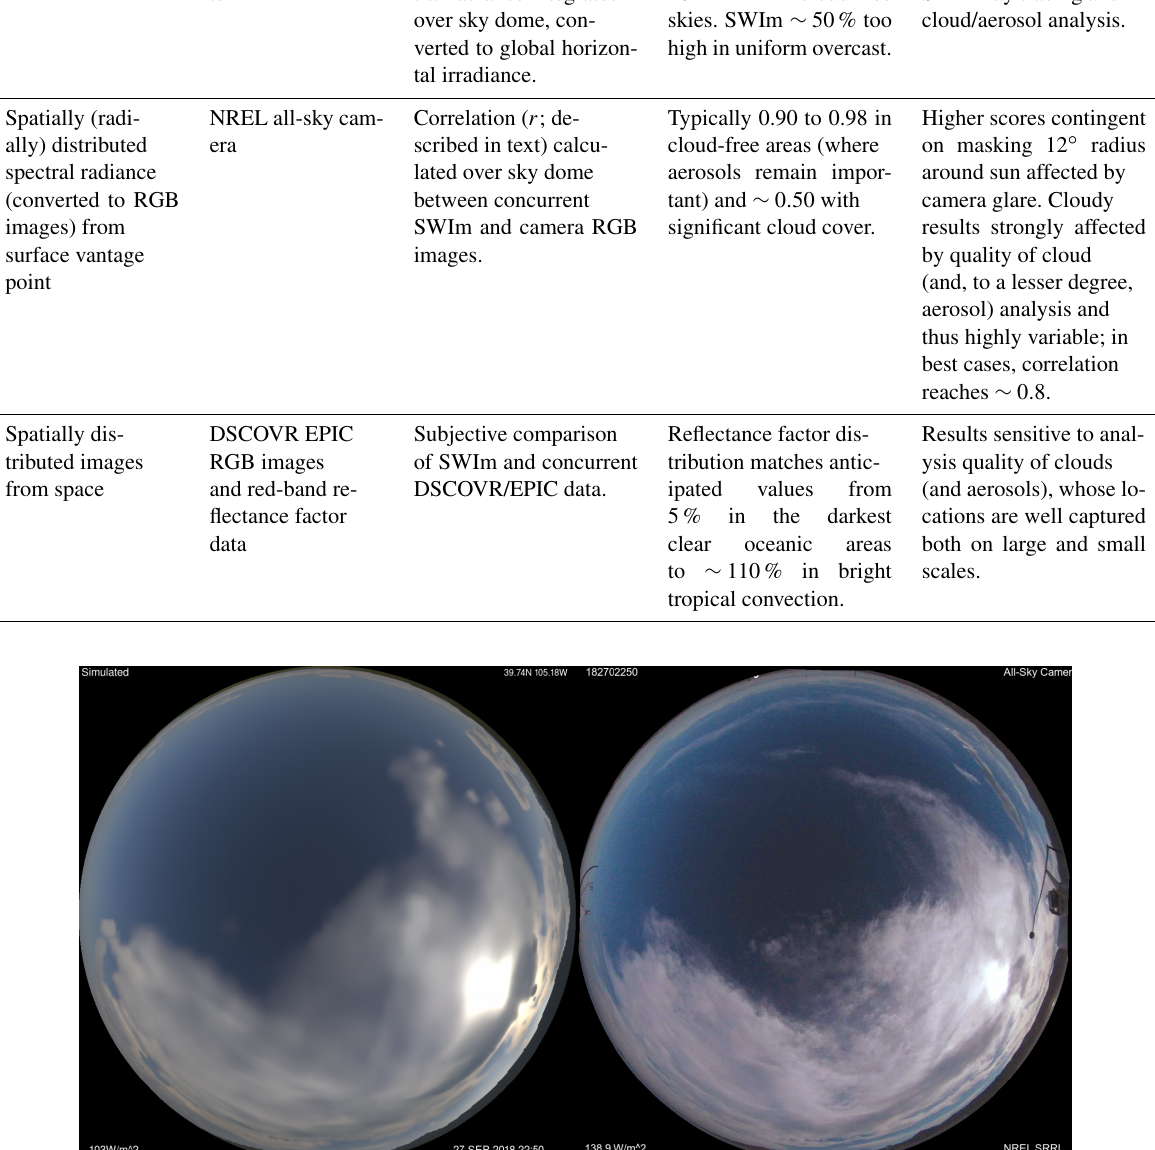
Figure 10. Comparison of observed (right) to simulated (left) polar equidistant projection images showing the upward looking hemisphere from a ground-based location in Golden, Colorado, on 27 September 2018 at 22:50UTC. LAPS analysis fields are used for the simulated